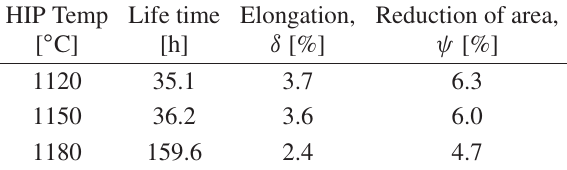
Table 3. Effect of HIP temperature on creep properties of FGH95